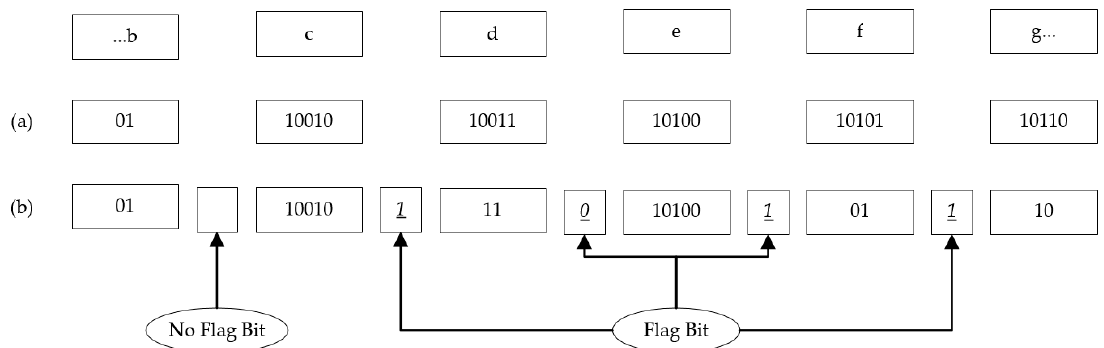
Figure 10. Bit Sequence of encoding algorithms. ( a ) Huffman encoding algorithm. ( b ) Proposed encoding algorithm.